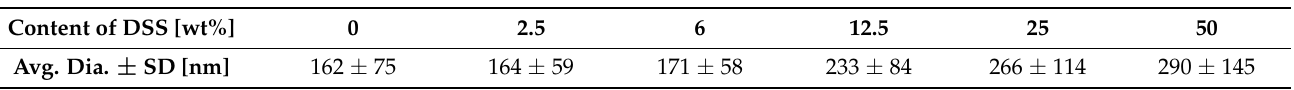
Figure 1. SEM micrographs comparing the fiber diameter and the distribution of diameters of pure poly( ε -caprolactone) (PCL) ( a ) and diclofenac sodium salt (DSS)-loaded PCL mats: PCL/2.5%DSS ( b ), PCL/6%DSS ( c ), PCL/12.5%DSS ( d ), PCL/25%DSS ( e ), and PCL/50%DSS ( f ) fibrous mats. The values of diameters and their distribution are depicted in Table 2. Table 2. Values of average diameters (avg. dia.) of the tested fibers and distribution of average diameters in the PCL and PCL/DSS electrospun